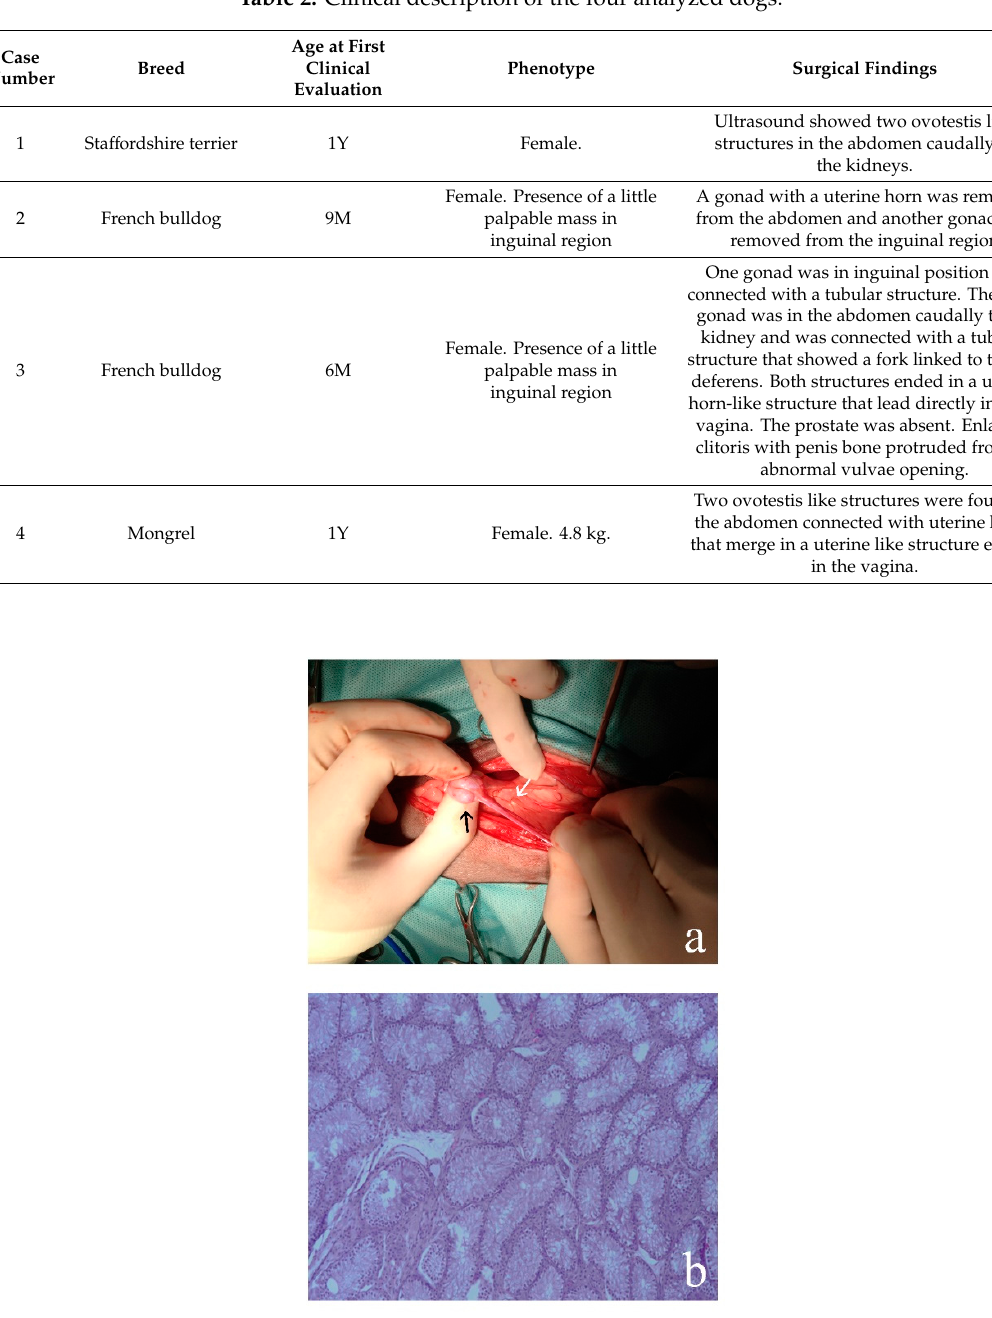
Figure 2. ( a ) Gonadectomy of Case 2 in which atrophic testis (black arrow) with uterine horn (white arrow) are showed; ( b ) histology of the atrophic testes in which is evident the structure of the tubules covered by Sertoli cells and without germ lines (20 × ) (see also supplementary Figure S1 for comparison). Hematoxylin–eosin (HE)